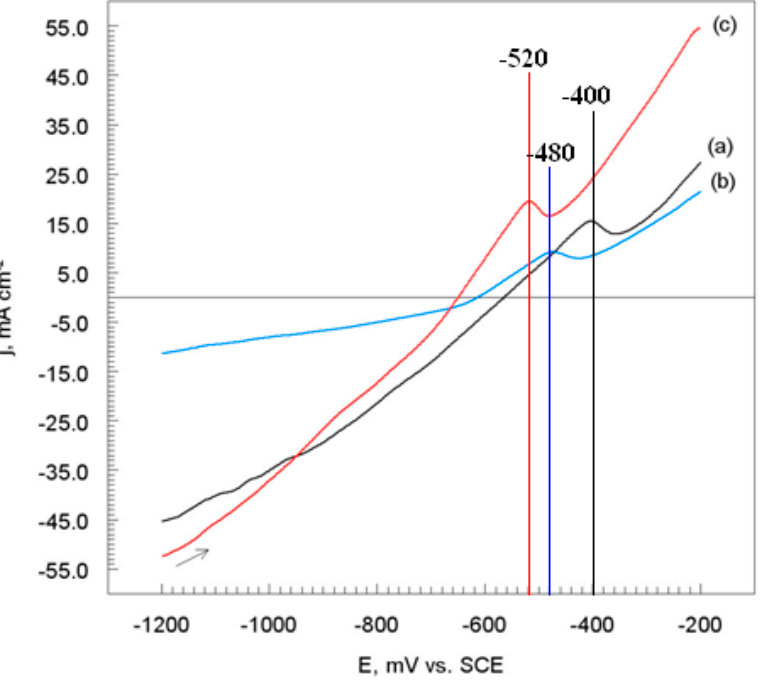
Figure 8. Potentiodynamic polarization curves of the Al/Cu alloy: ( a ) before and after heat treatment at: ( b ) 400 °C or ( c ) 600 °C. Solutions contained 1.2 M Cl − , pH 1.5, d E /d t 1 mV s − 1 .